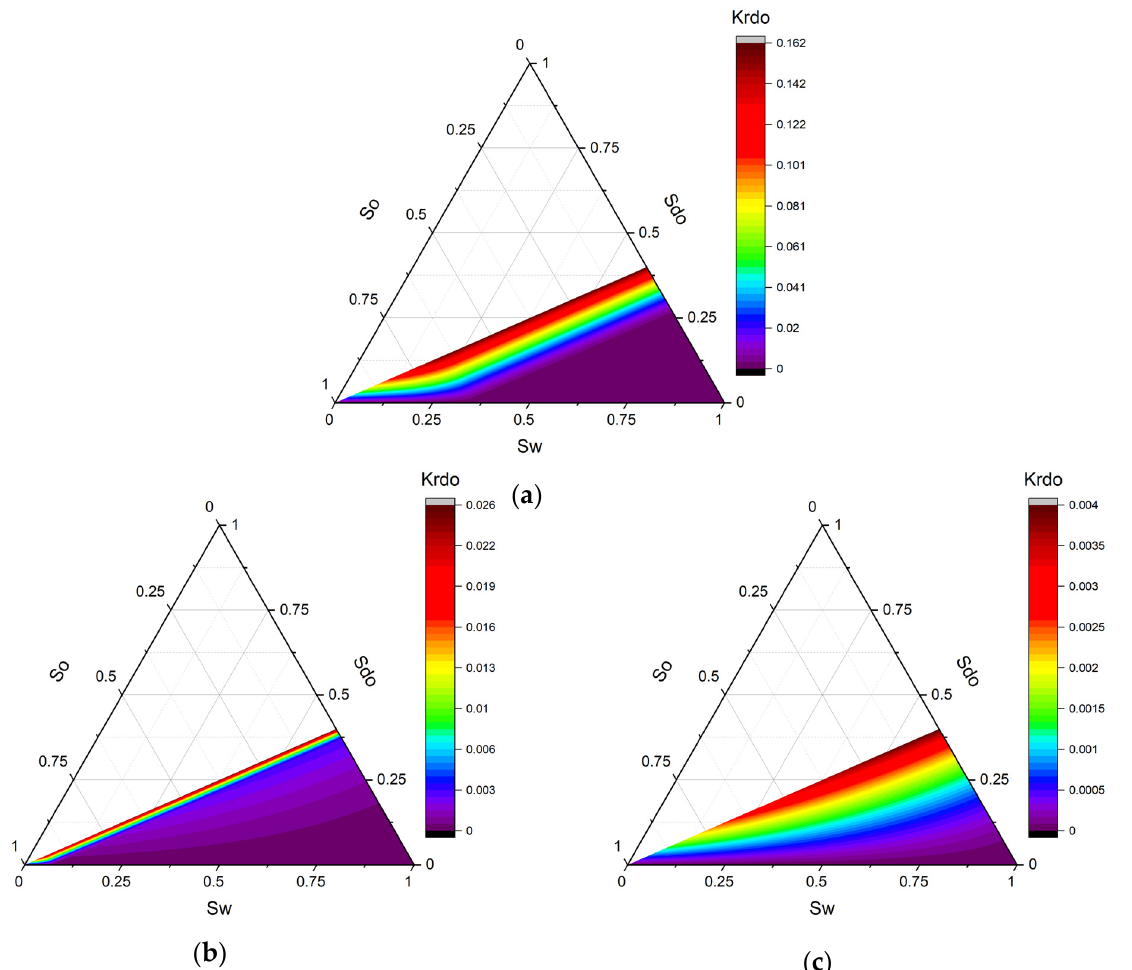
Figure 12. The relative permeability ternary diagrams of the dispersed oil phase with φ d = 0.4, Ca = 10 − 4 , and different λ . ( a ) λ = 0.6; ( b ) λ = 0.9; and ( c ) λ = 1.2 .